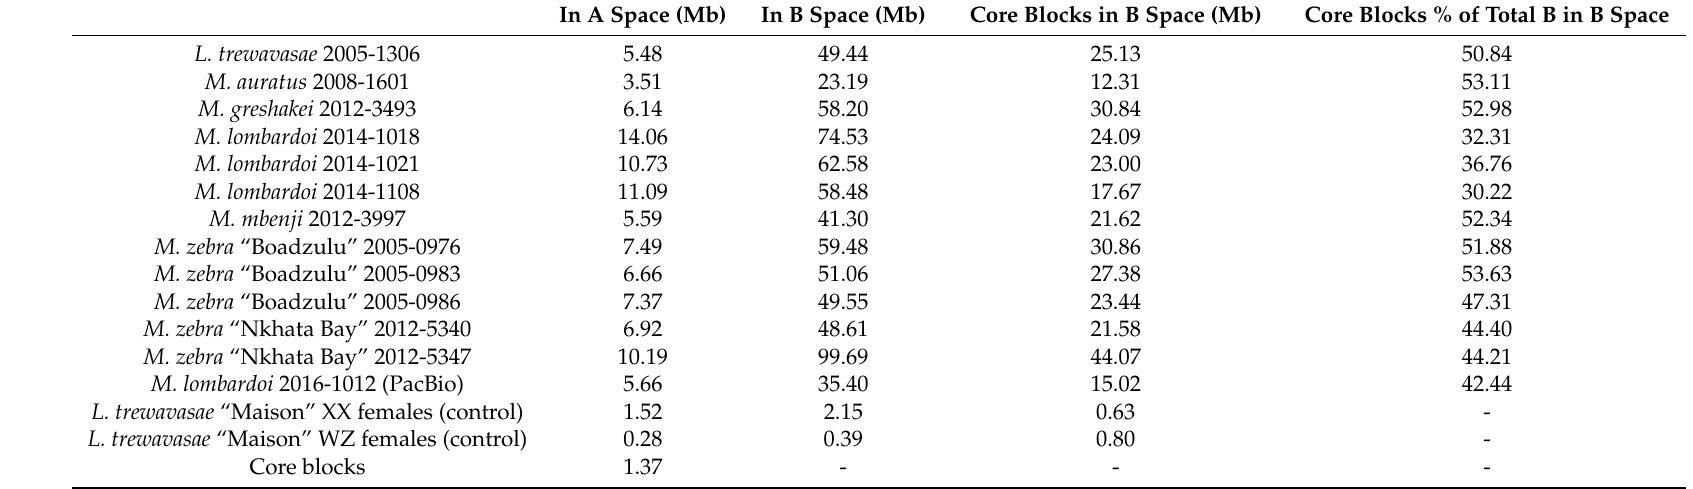
Table 3. Total estimated length of B sequence identified in the coverage ratio analysis. The total length of sequence identified in the reference genome, or “in A space”, is provided for all B individuals, the two NoB controls, and the core block set (the blocks shared by at least 12 of the 13 B individuals). The total length of these blocks, after accounting for their copy number on the B chromosome (i.e., “in B space”) is provided for the 13 B individuals and 2 NoB controls. Similarly, the total length of just the core blocks, accounting for copy number, are provided for the 13 B individuals and 2 NoB controls. Finally, the portion of the total estimated B chromosome length that is represented by the core blocks is provided for the 13 B